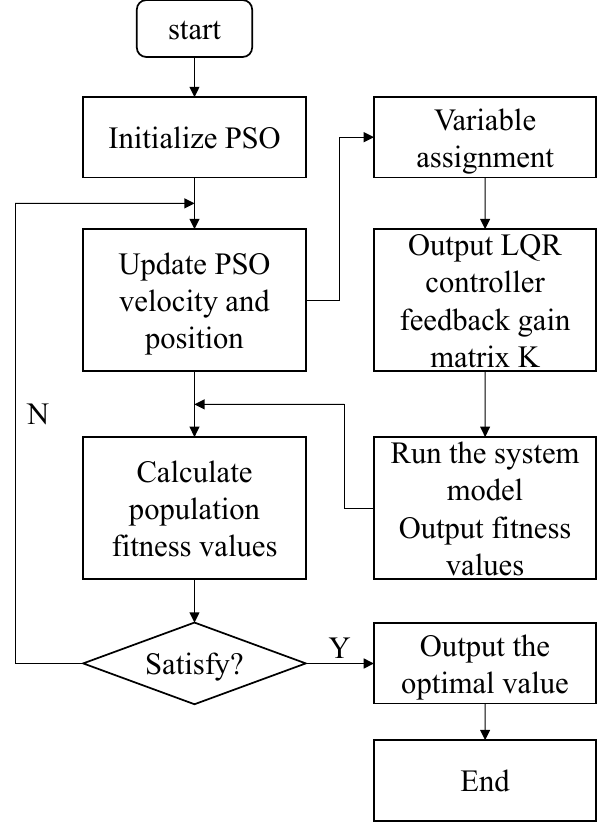
Figure 4. Flow chart of the PSO algorithm optimize LQR parameters.